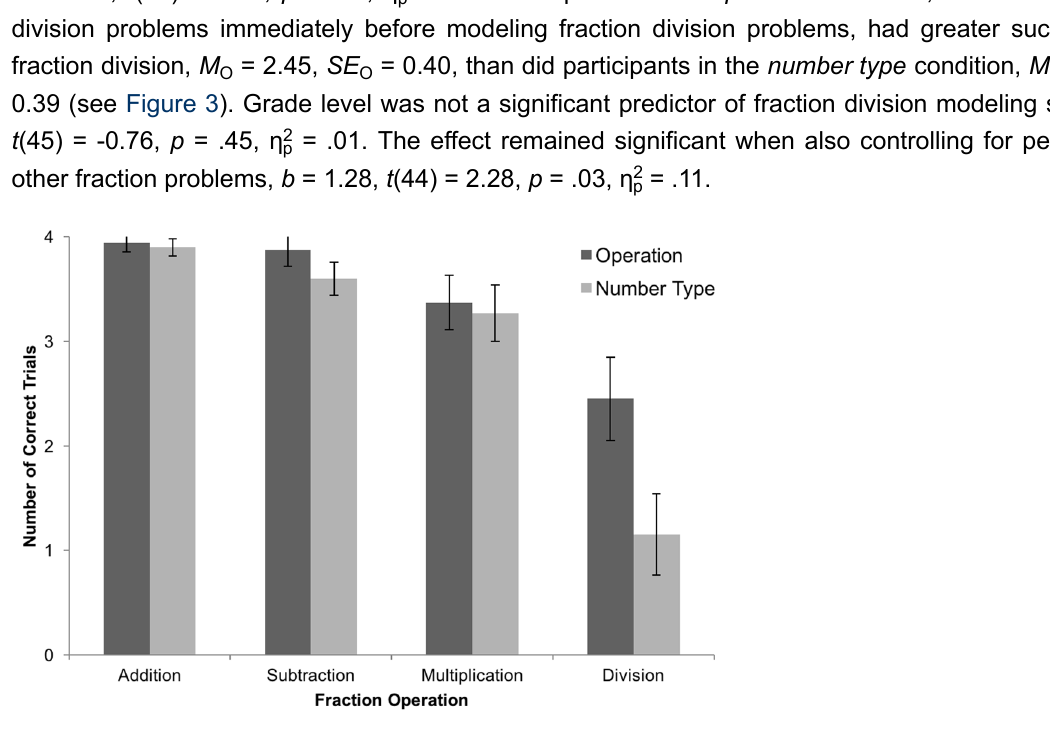
Figure 3. The average number of correctly modeled trials for each fraction operation, out of four, by experimental condition, controlling for grade level. Error bars represent the standard errors of each point estimate from each